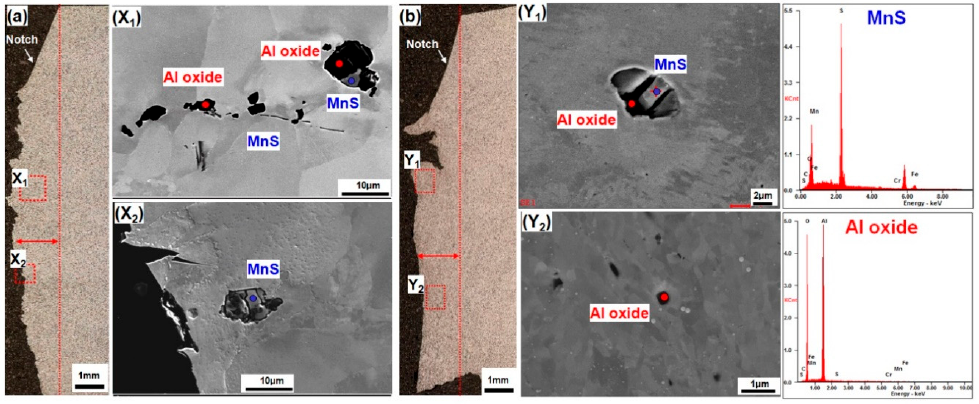
Figure 4. OM and SEM images of inclusions in the cross-section of the ( a ) 28J and ( b ) 386J specimen.